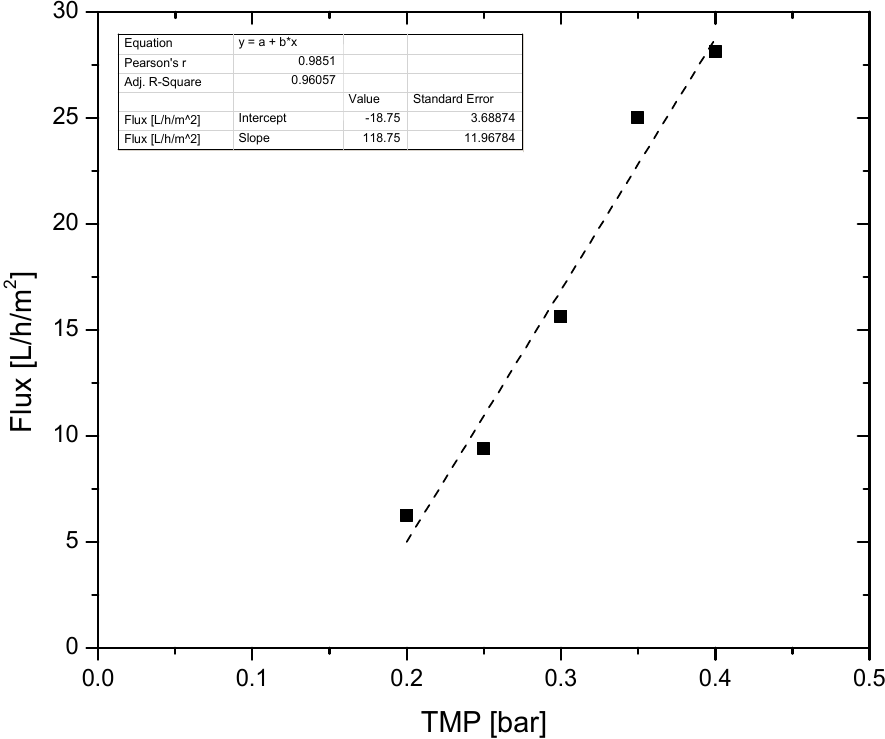
Figure 3. UF membrane observed permeate flux as a function of TMP.